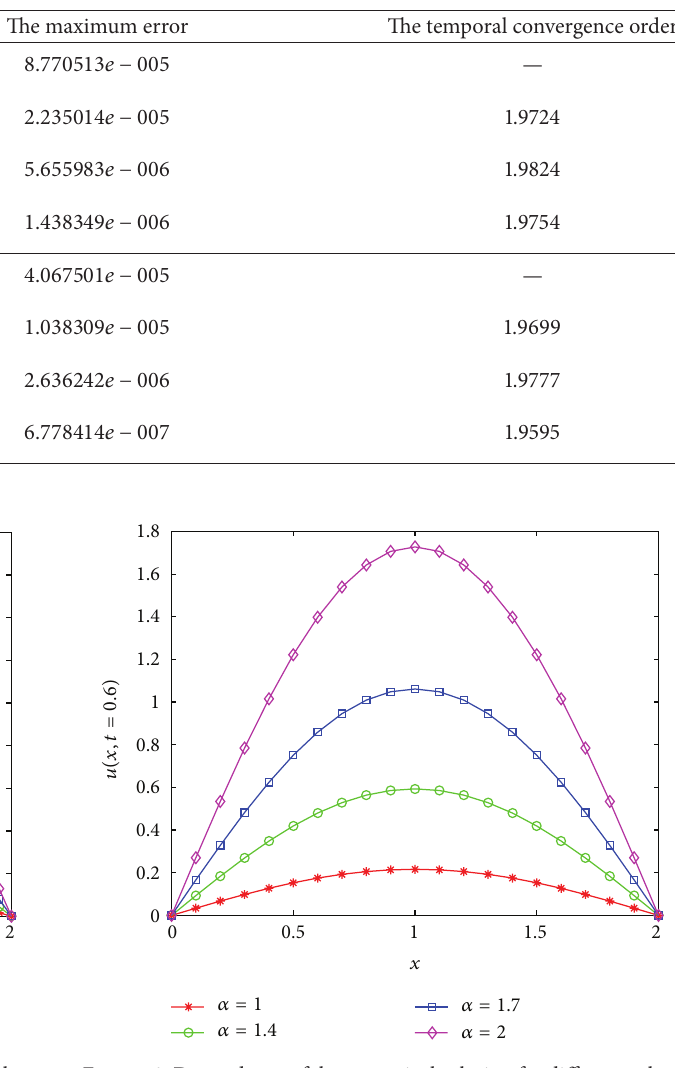
Figure 2: Dependence of the numerical solution for different values of 𝛼 by Numerical Algorithm I (see (38)) with 𝜏 = 0.0001, ℎ = 0.05